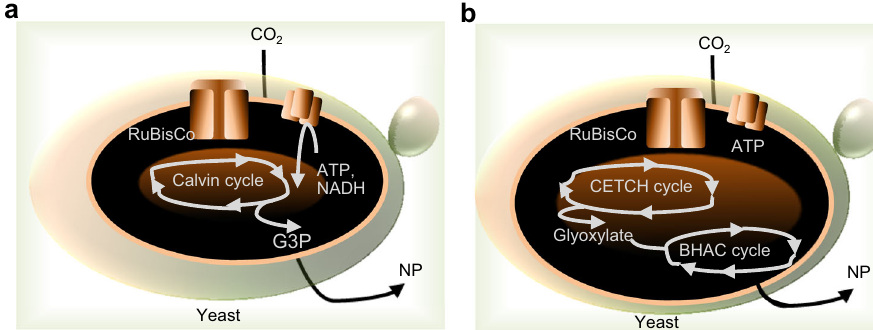
Fig. 3 | Synthetic routes for carbon-negative manufacturing to produce NP in yeast.a TheyeastisengineeredfortheCalvincycletoconvertCO 2 toG3P,RuBisCo expression, and enhanced production of ATP and NADPH. b The yeast is engi- neered for the synthetic CETCH cycle to produce glyoxylate from CO 2 , the β - hydroxyaspartate cycle to convert glyoxylate to NP, RuBisCo expression, and